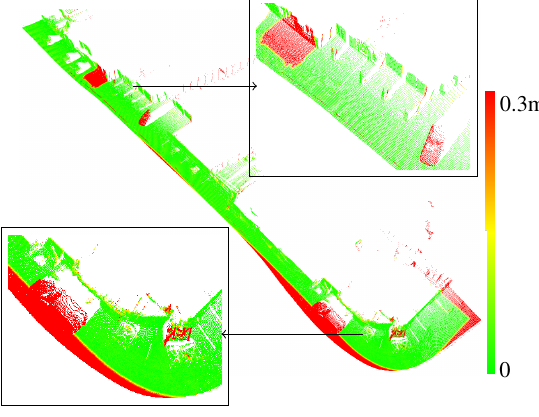
Figure 10: Point to triangle